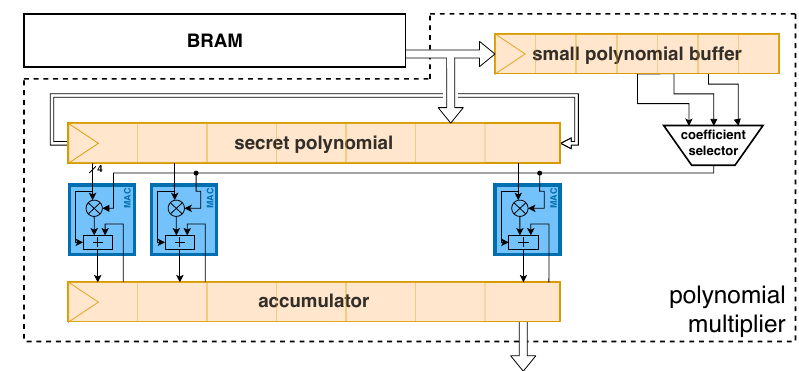
Figure 4: The polynomial multiplier architecture. Blue blocks denote multiply-and- accumulate (MAC) units, orange blocks are registers and wide arrows represent 64-bit input/output to the